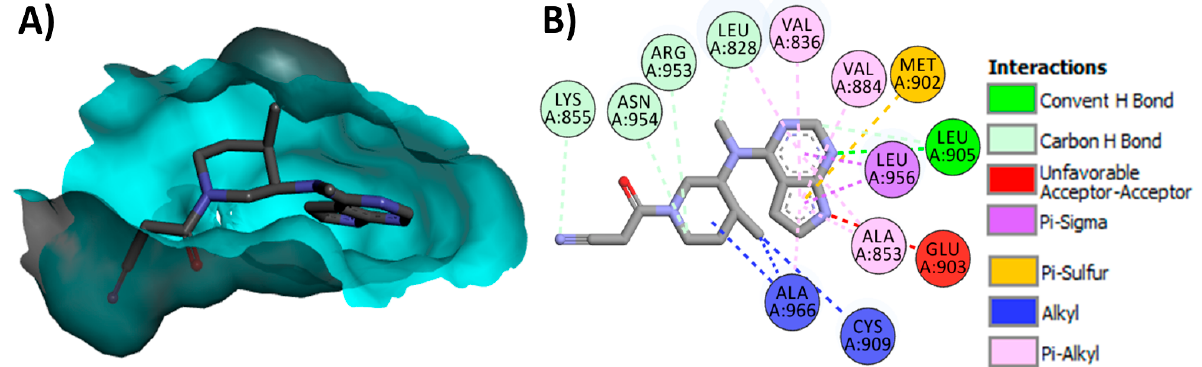
Figure 62. Binding modes of tofacitinib (shown as sticks) into JAK3 (pdb: 3LXK): ( A ) 3D binding mode, receptor depicted as a hydrogen bond surface; ( B ) 2D binding mode showing different types of interactions with JAK3; hydrogen atoms were omitted for clarity; this figure was generated using Discovery Studio Visualizer (V16.1.0.15350).